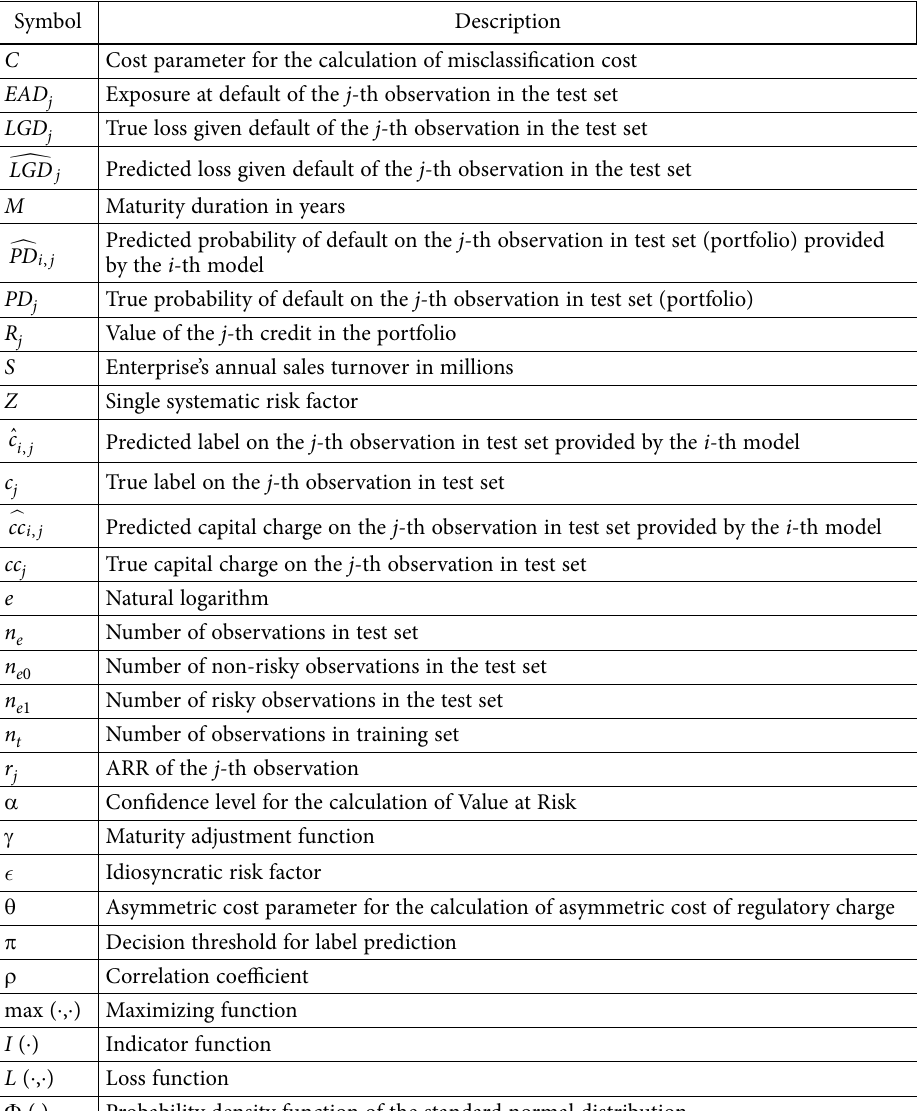
Table A2. List of mathematical symbols Symbol Description C Cost parameter for the calculation of misclassification cost EAD j Exposure at default of the j -th observation in the test set LGD j True loss given default of the j -th observation in the test set  j LGD Predicted loss given default of the j -th observation in the test set M Maturity duration in years Predicted probability of default on the j -th observation in test set (portfolio) provided  , i j PD by the i -th model PD j True probability of default on the j -th observation in test set (portfolio) R j Value of the j -th credit in the portfolio S Enterprise’s annual sales turnover in millions Z Single systematic risk